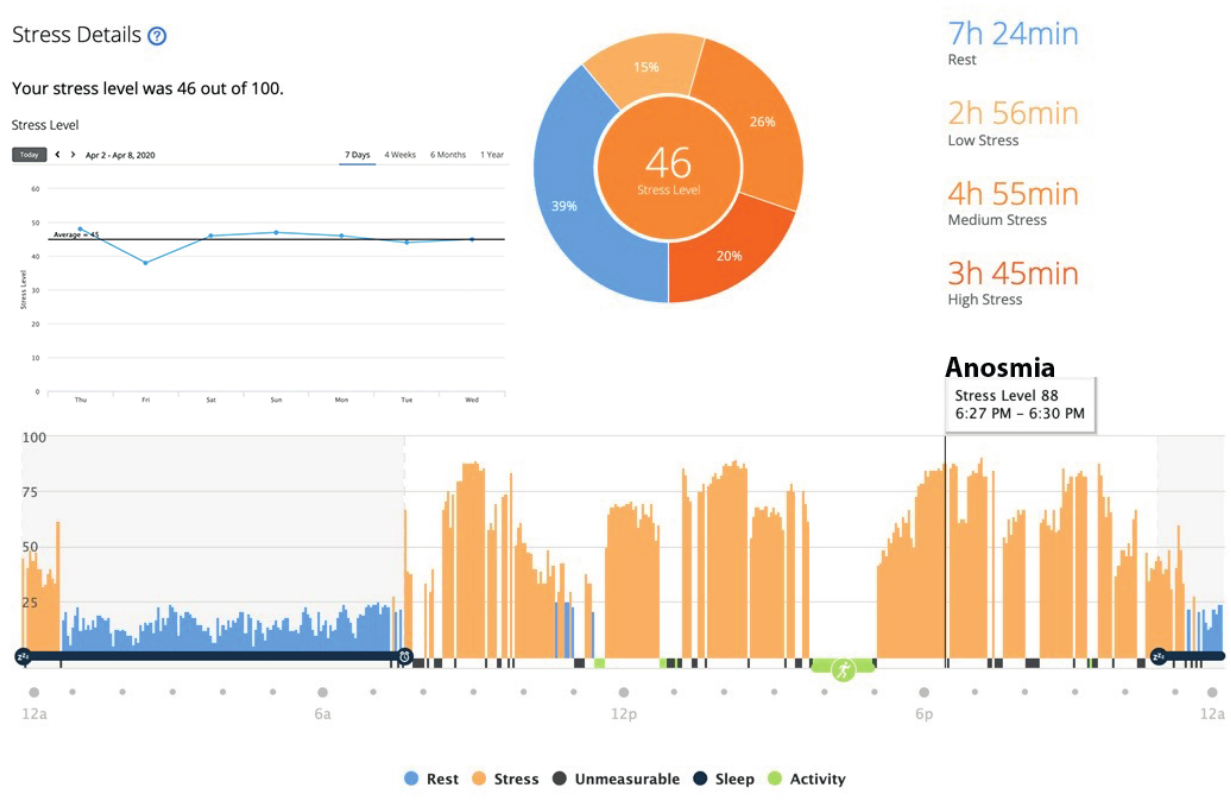
Figure 2. Stress